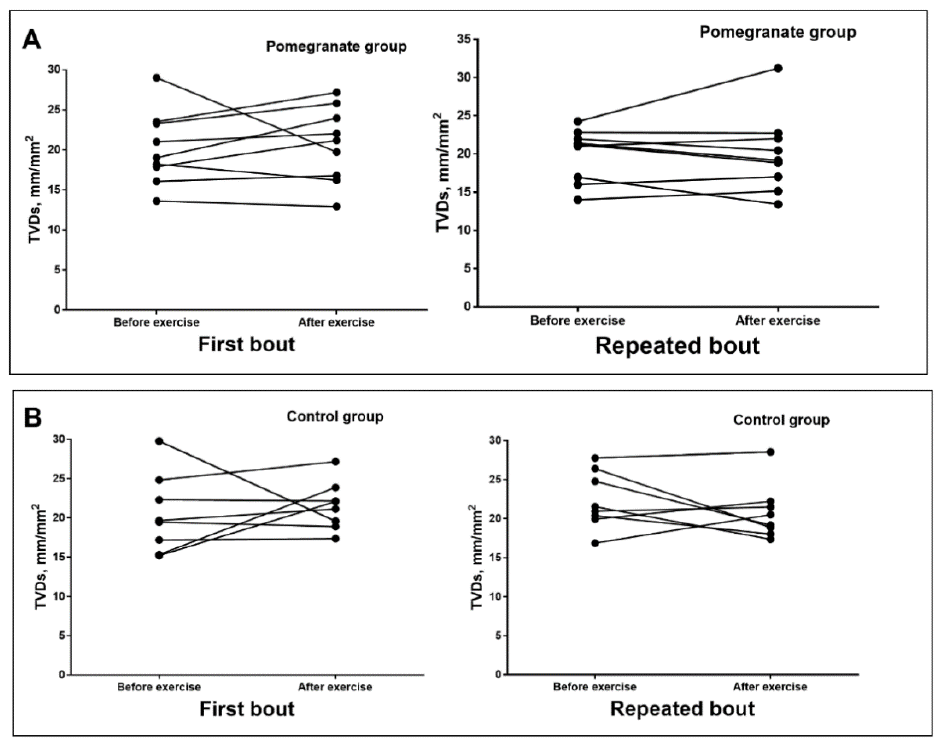
Figure 2. Change of total vessels density of small vessels (TVDs) in pomegranate ( A ) and control ( B ) groups.